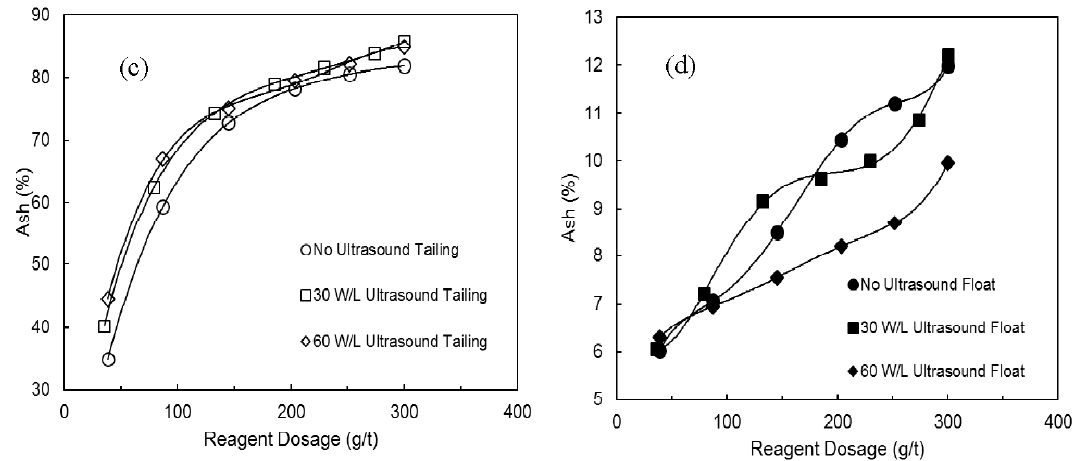
Figure 3. ( a ) Combustible recovery; ( b ) separation efficiencies and ash values of the ( c ) tailings and ( d ) froth product for two ultrasonic power levels with varying reagent dosages.